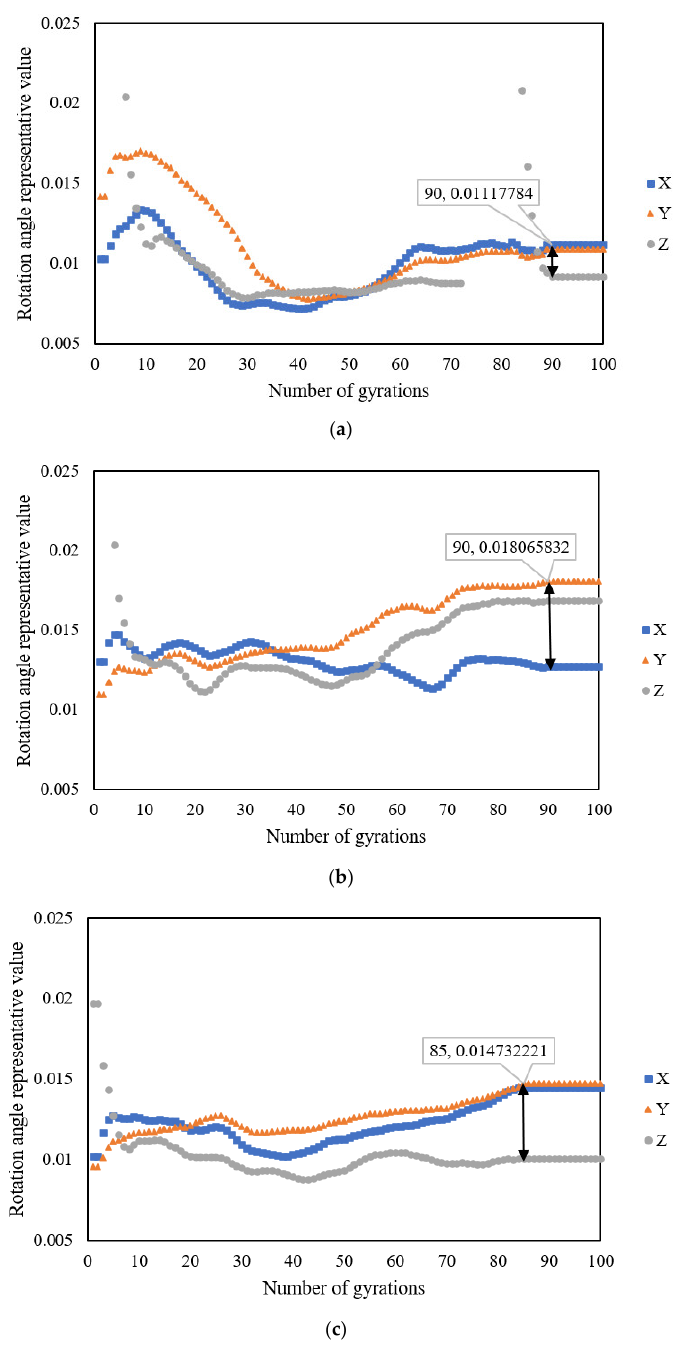
Figure 12. Representative rotation angle value with different compaction temperatures: ( a ) 160 °C, ( b ) 170 °C, and ( c ) 180 °C.